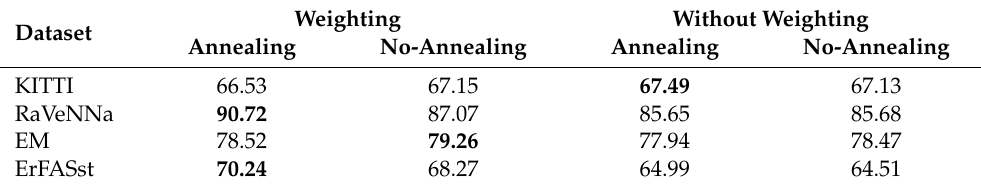
Table 7. SmartSamplingAugment ablation study analyzing the impact of weighting the augmenta- tions and annealing the probability hyperparameter over the whole epochs for different datasets. We evaluated each experiment three times using different seeds to obtain the mean IoU. For the experiments without annealing, we set the probability P of applying augmentations to